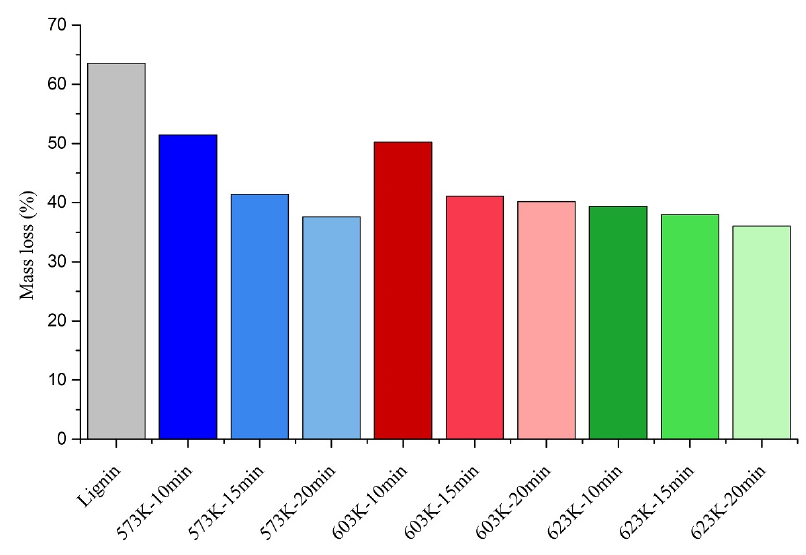
Figure 6. Mass loss of lignin and the HTL chars.